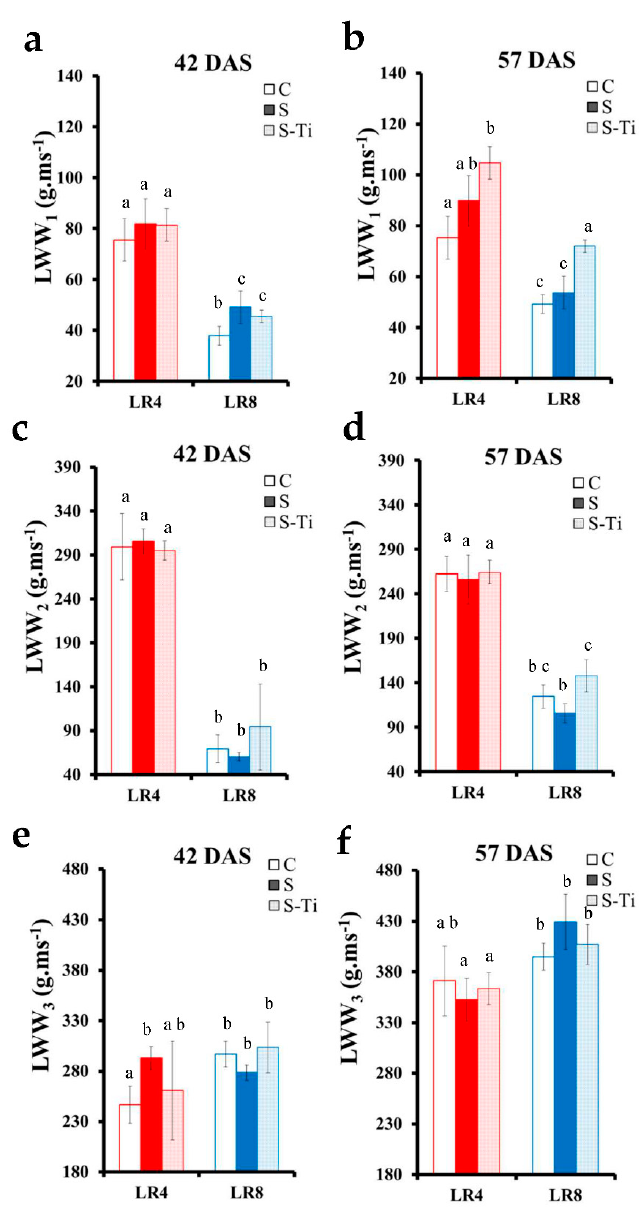
Figure 5. LWW (leaf water weight) in g · m − 2 of the first ( a , b ), second ( c , d ) and last peaks ( e , f ) obtained in leaves from two ranks and for all treatments at 42 DAS ( a , c , e ) and 57 DAS ( b , d , f ). Bars represent standard deviation. Different letters means statistical differences ( p < 0.05).